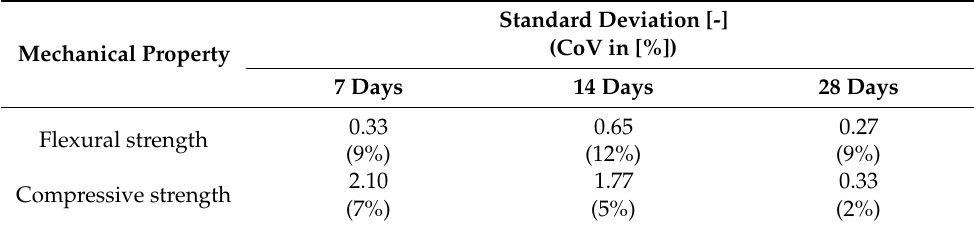
Table 7. Density of samples demolded after 7, 14 or 28 days, measured after 28 days of curing.